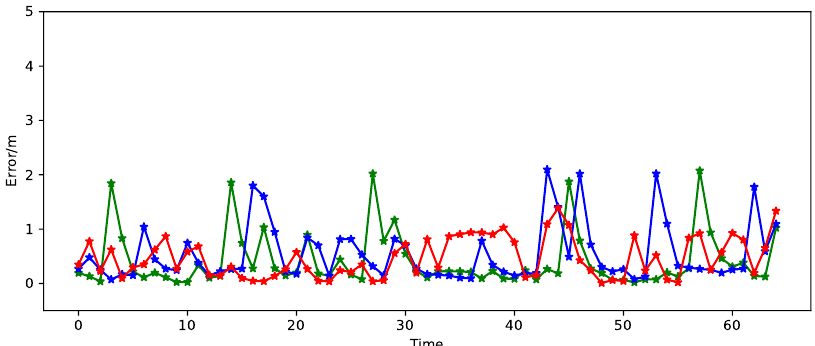
Figure 17. Error of localization results. T1 corresponds to the tag of the position of the red five-pointed star in the static experiment, T2 corresponds to the position of the blue five-pointed star, and T3 corresponds to the position of the green five-pointed